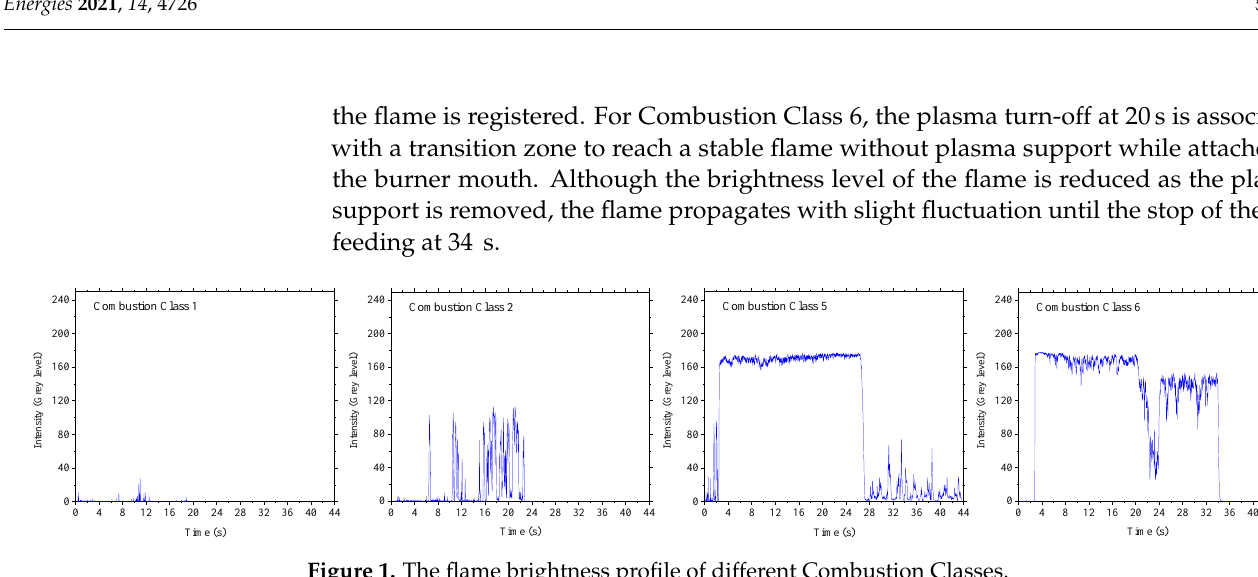
Figure 1. The flame brightness profile of different Combustion Classes. Since the tests were demonstrated within short time frames, burnout measurements were not plausible. Hence, to evaluate the combustion process, a criterion was developed to provide quantitative information on the combustion reactions. “Combustion Degree” was defined as the share of burned fuel in the fuel stream calculated at a specific time after ignition. For these experiments, the amount of burned fuel 30 s after the ignition initiation was calculated based on the measured O at the bottom of the reactor, 5.25 2